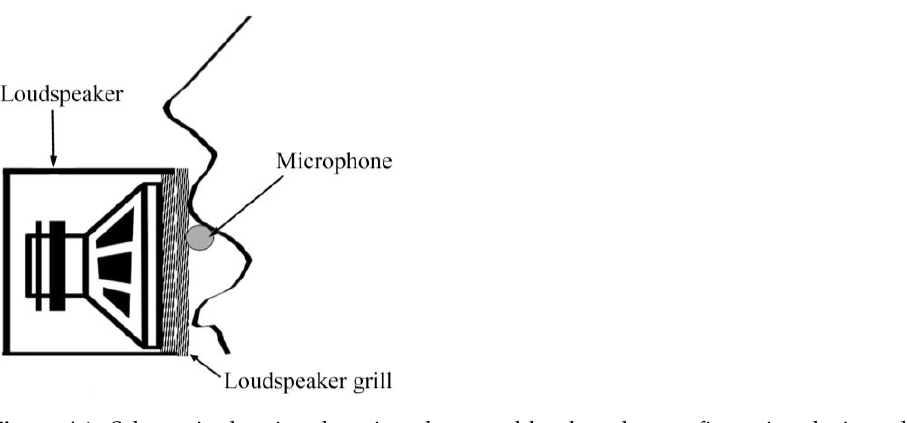
Figure A1. Schematic showing the microphone and loudspeaker configuration during a human subject measurement.